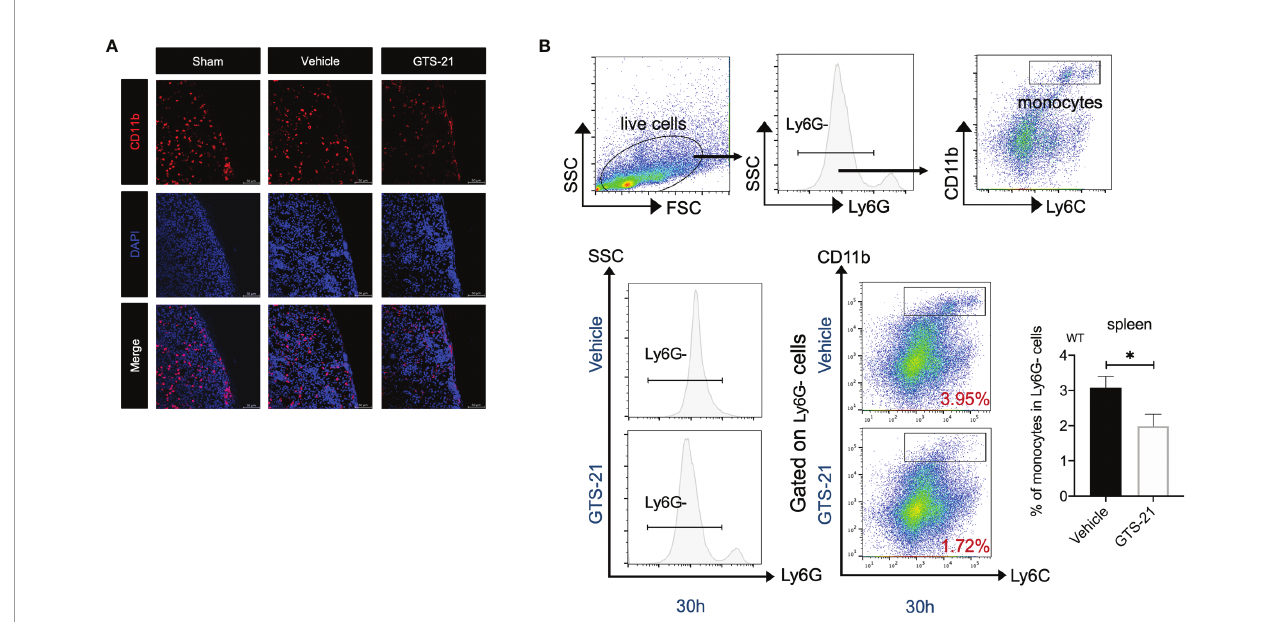
FIGURE 5 | The spleen is required for improved bacterial clearance and enhanced monocytes recruitment in the peritoneal cavity during septic peritonitis. GTS-21 or vehicle was injected intraperitoneally 12h after CLP procedure and repeated every 12h. At indicated intervals, spleen samples were obtained from sham-operated, vehicle or GTS-21 treated mice 30h post-operation (n=5 mice/group) and were visualized with confocal microscopy as described in Materials and Methods. Representative images of spleen sections immunostained for CD11b are shown in (A) . (B) Spleens were harvested from vehicle or GTS-21 treated mice 30h after CLP, and cell suspensions were prepared (n=8 mice/group) and stained for monocytes markers (CD11b+Ly6G-Ly6C+). Percentages of monocytes were measured by fl ow cytometry. Results are expressed as mean ± SEM. *p < 0.05 for GTS-21 vs